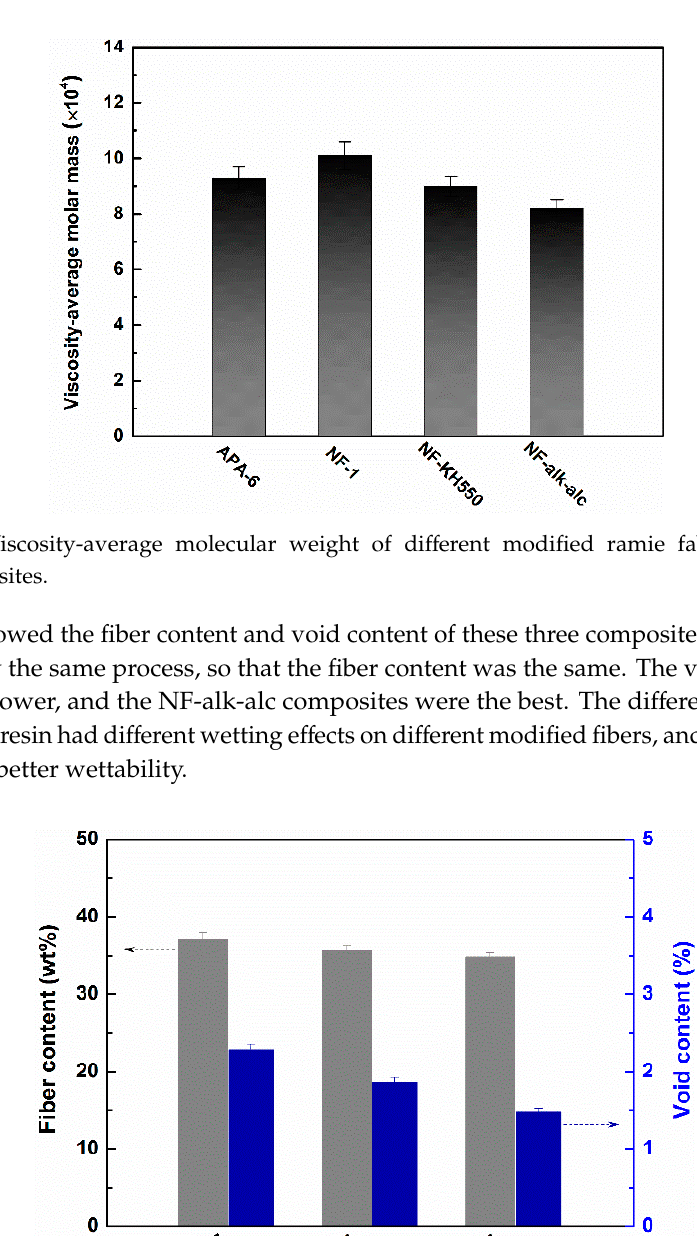
Figure 8. The degree of conversion (gray columnar) and crystallinity of different modified ramie fabrics reinforced APA-6 composites (blue columnar).